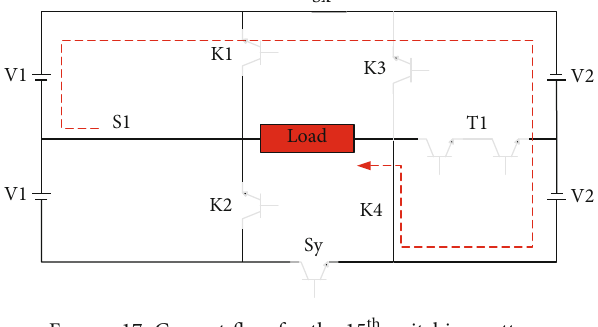
Figure 17: Current fl ow for the 15 th switching pattern.